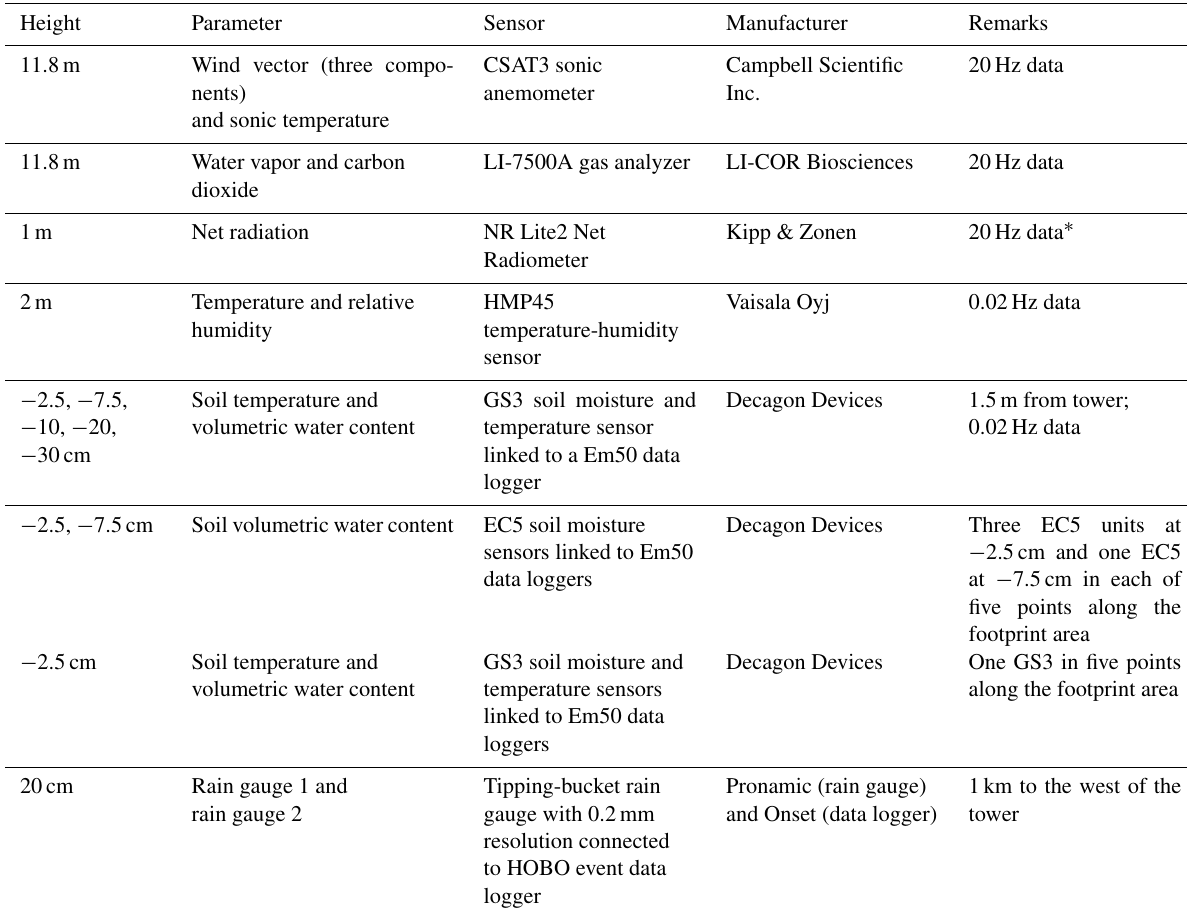
Table 1. Meteorological sensors mounted on the slim tower and in its immediate surroundings.